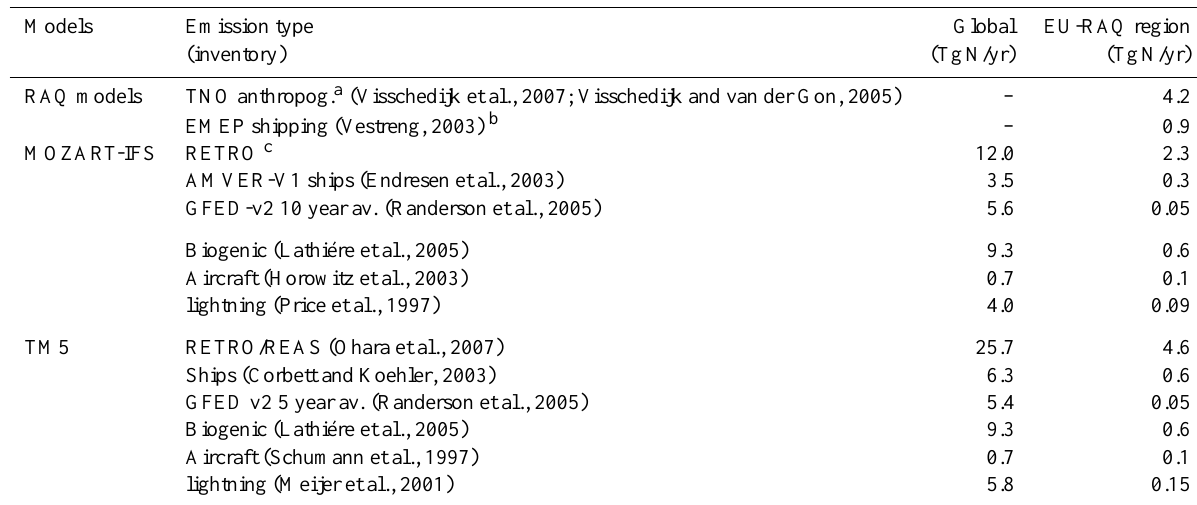
Table 2. Specification of NO x emission inventories, in terms of TgN / yr.